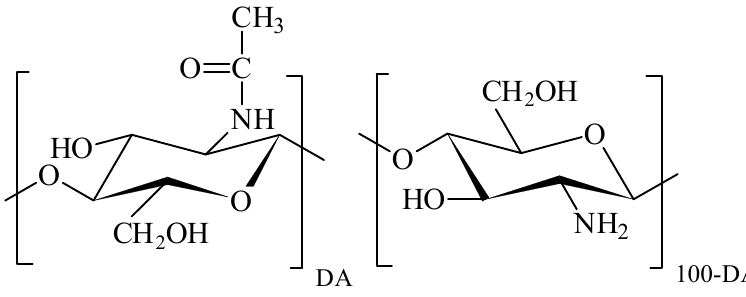
Figure 1. Chemical structure of chitosan monomer units: acetylated to the left, deacetylated to the right. DA is the degree of acetylation.